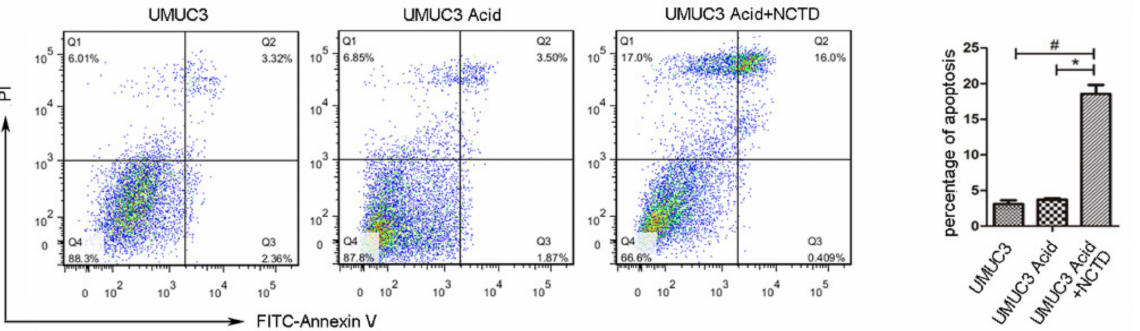
Figure 2. NCTD induces apoptosis of bladder cancer cells under acidic environment. ( A ) EJ and UMUC3 cells were treated with an increasing concentration of NCTD (0–320 µ M) for 24 h in physi- ological (pH 7.2–7.3) and acidic culture medium (pH 6.6–6.8). Cell viability was measured by the MTS assay. The logarithm of the NCTD concentration was taken, and then a curve was fitted to calculate the IC50 value. ( B ) EJ and UMUC3 cells were treated with NCTD (3 µ M) in acidic medium, cell apoptosis was measured with Annexin-V/PI double-stained flow cytometry. Data are presented as the mean ± SD ( n = 3), # p < 0.05 vs. the control group, * p < 0.05 vs. the acid group.